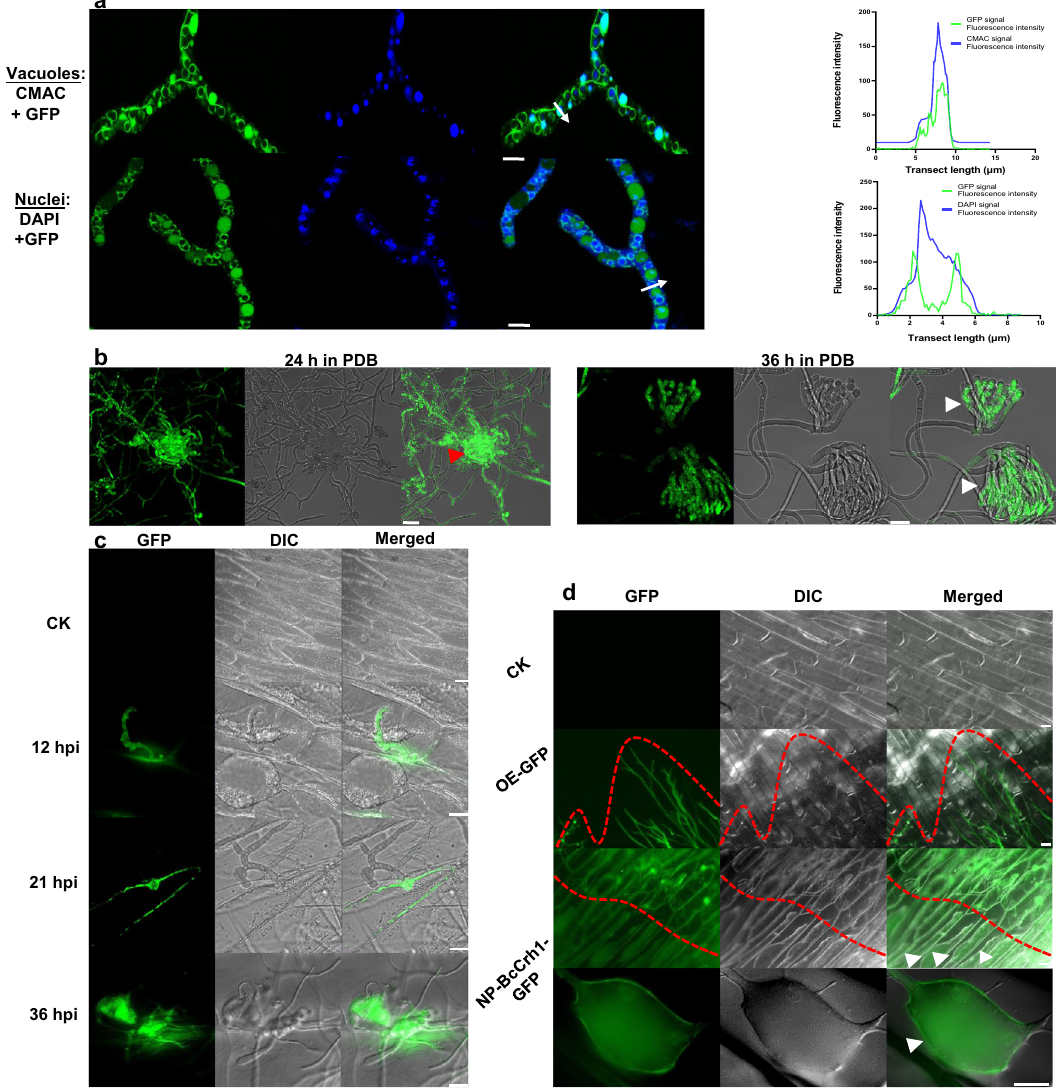
Fig. 5 Subcellular localization of BcCrh1 during saprophytic growth and host infection. a Intracellular localization of BcCrh1 during saprophytic growth. Spores of BcCrh1-GFP strain were cultured in liquid PDB medium for 12 h, vacuoles (top) and nuclei (bottom) were stained with CMAC and DAPI, respectively, and samples were visualized using a Confocal microscope. Scale bars = 5 μ m. The graph shows fl uorescent intensity pro fi les of GFP/CMAC signals (top) and GFP/DAPI signals (bottom) in transects (white arrowheads). Y axis, GFP and CMAC or DAPI fl uorescence intensity; X axis, transect length ( μ m). b Differential distribution of BcCrh1 in mycelia and infection cushions in vitro. Spores were germinated on a glass slide in PDB medium. At 24 h the GFP signal accumulates in the entire mycelium and in initiating infection cushions (left, marked with red arrow), at 36 h the signal is detected only in the mature infection cushions (right, indicated with white arrows). Scale bar = 20 μ m. c – d Onion epidermis infection assay with cytoplasmic GFP and BcCrh1-GFP strains. c Images showing secretion of the protein from hyphal tips at early time points (12, 21 hpi) and from infection cushions at 36 hpi. Scale bars = 50 μ m at 12 hpi and 20 μ m in all other images. d Intracellular localization of secreted BcCrh1-GFP protein in plasmolysed onion cells 45 hpi. Infection area is marked by red dashed line. BcCrh1-derived GFP signal is observed in the cytoplasmic space of plasmolysed onion cells outside the invasion area (marked with arrows). Scale bars = 20 μ m. All the experiments were repeated three times with similar